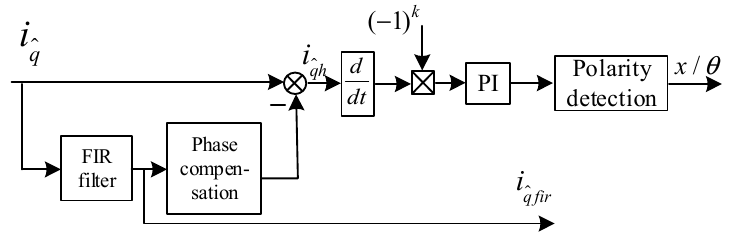
Figure 3. Structure of the position observer.